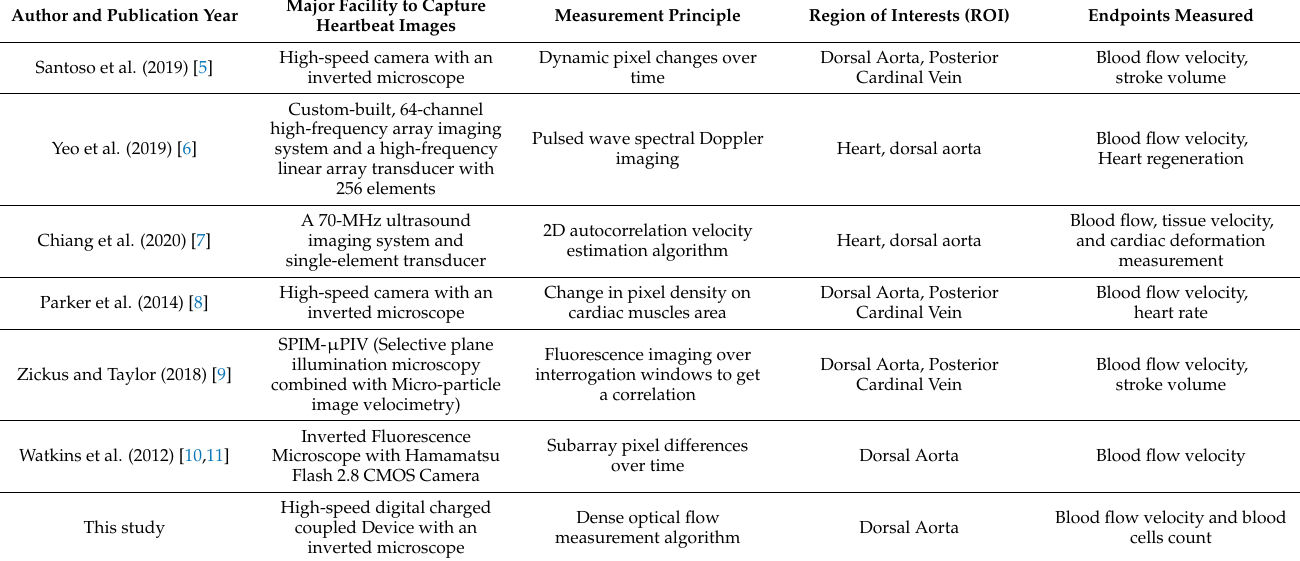
Table 1. Comparison of the previous methods used to detect blood flow velocity and associated endpoints in